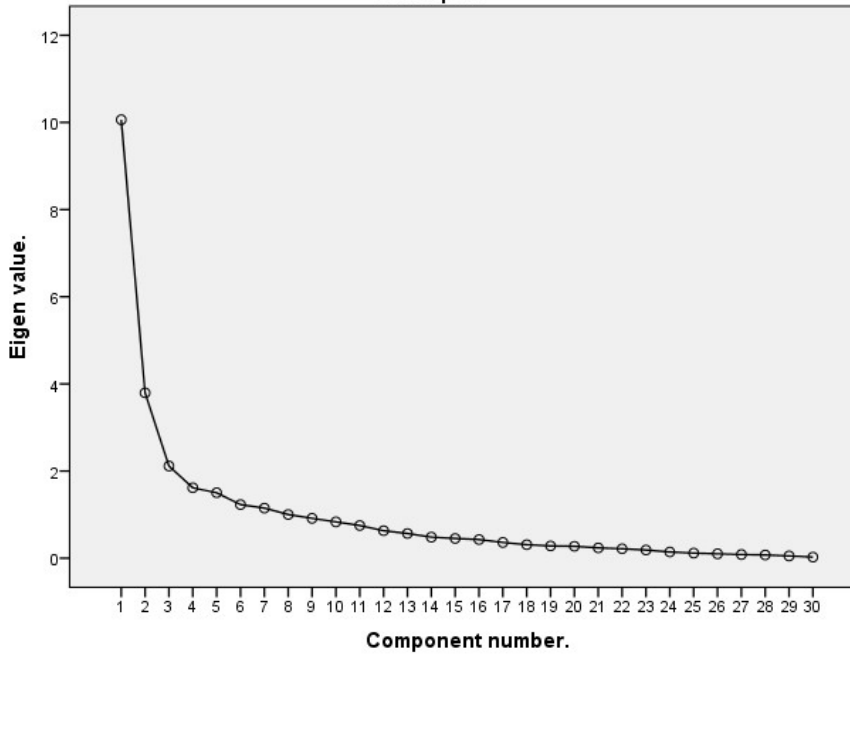
Figure 1. Scree plot for second round of principal components analysis of items assessing nutrition app